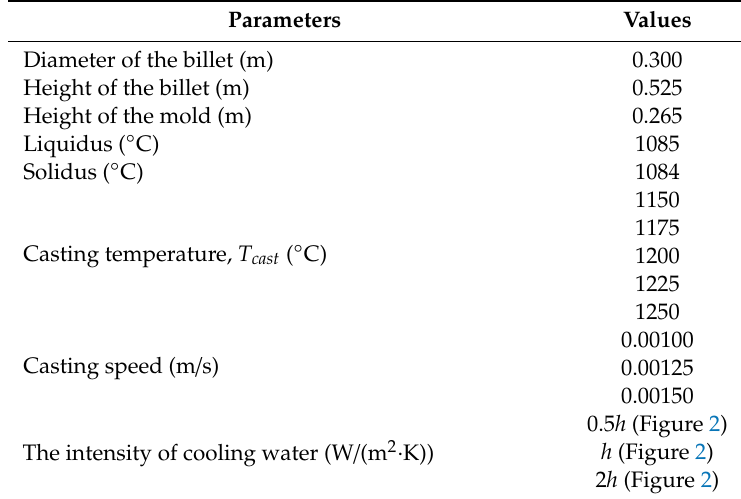
Table 1. Geometrical properties and operating conditions used in the